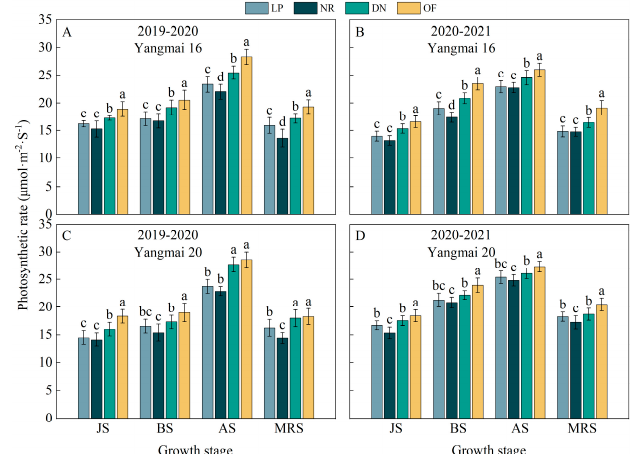
Figure 3. Effect of integrated cultivation practices on the photosynthetic rate of two wheat cultivars Yangmai 16 ( A , B ) and Yangmai 20 ( C , D ). LP, NR, DN, and OF indicate local practices, nitrogen reduction, planting density reduction and nitrogen reduction, and organic fertilizer, respectively. JS, BS, AS, and MRS indicate the jointing stage, booting stage, anthesis stage, and milky-ripe stage, respectively. Vertical bar represents the ± standard error of the mean. Different lowercase letters indicate the same period; the difference between different treatments was significant at the 0.05